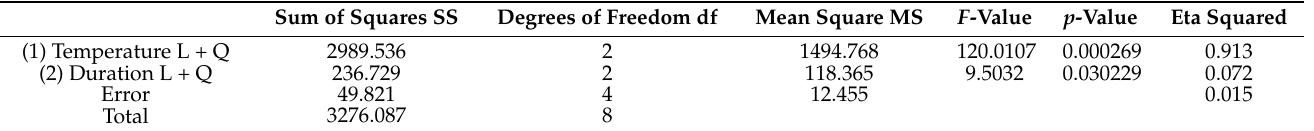
Table 9. Analysis of variance of the thickness of the toothed part of the boride